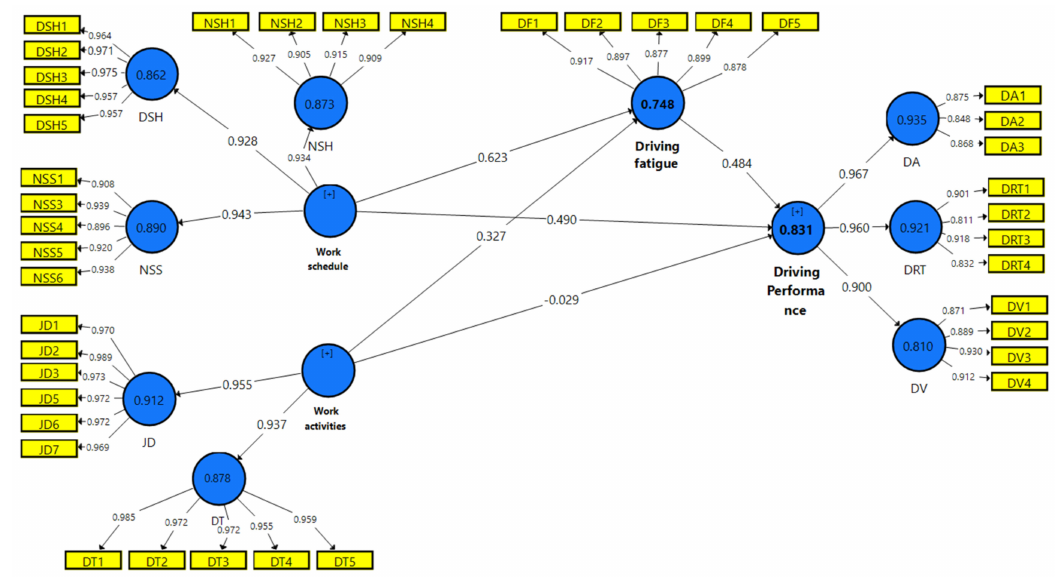
Figure 2. Measurement model test.